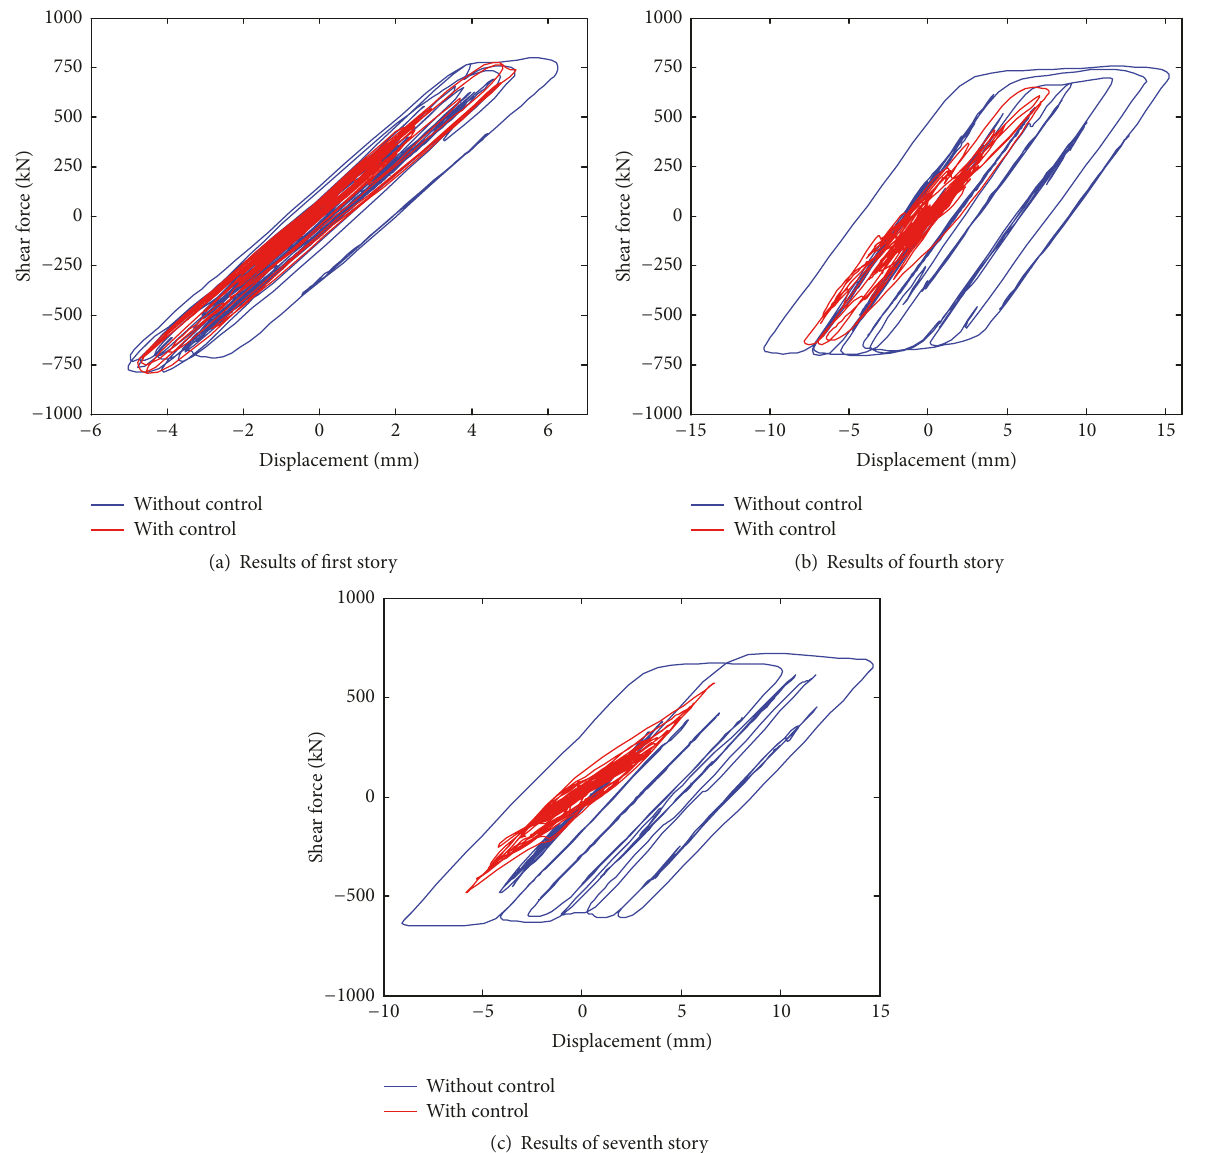
Figure 27: The hysteretic curves of the typical